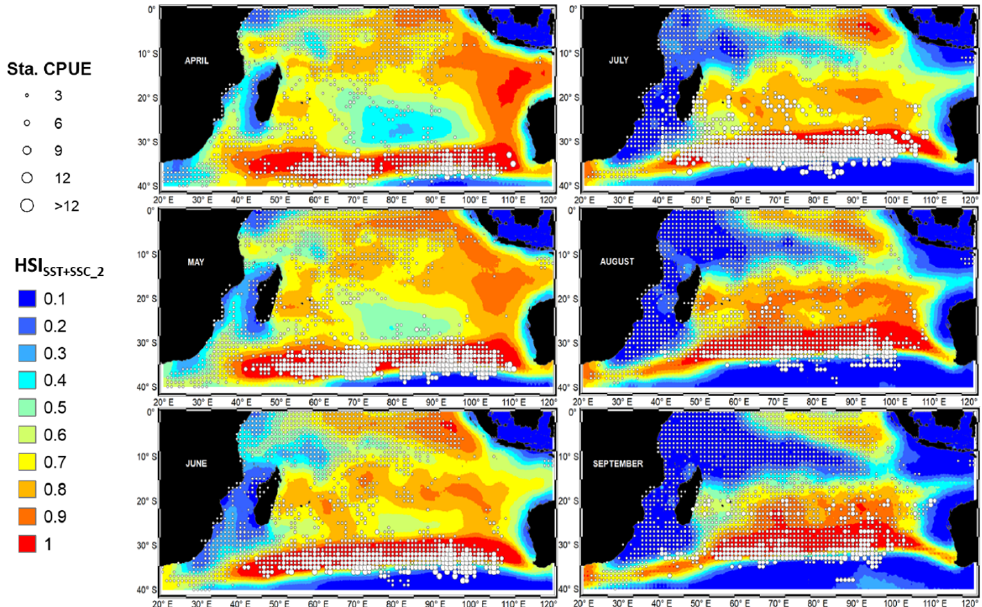
Figure 6. Monthly HSI predicted maps and albacore CPUE using an arithmetic mean model with SST and SSC_2